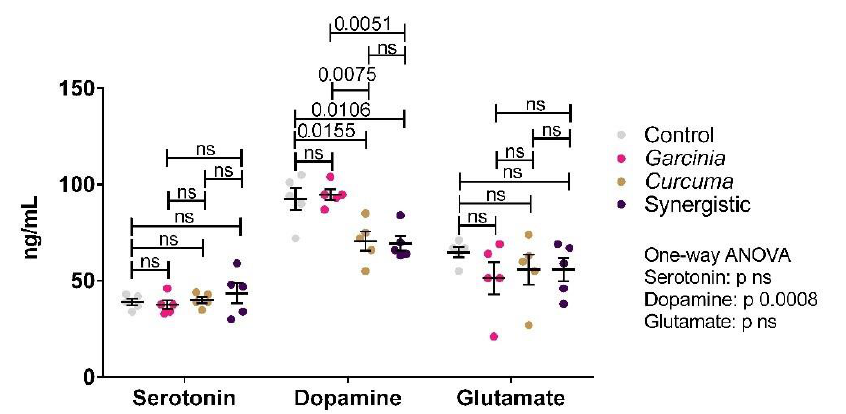
10 of 18 Figure 2. Effect of the independent and synergistic effects of Curcuma and Mangosteen extract on